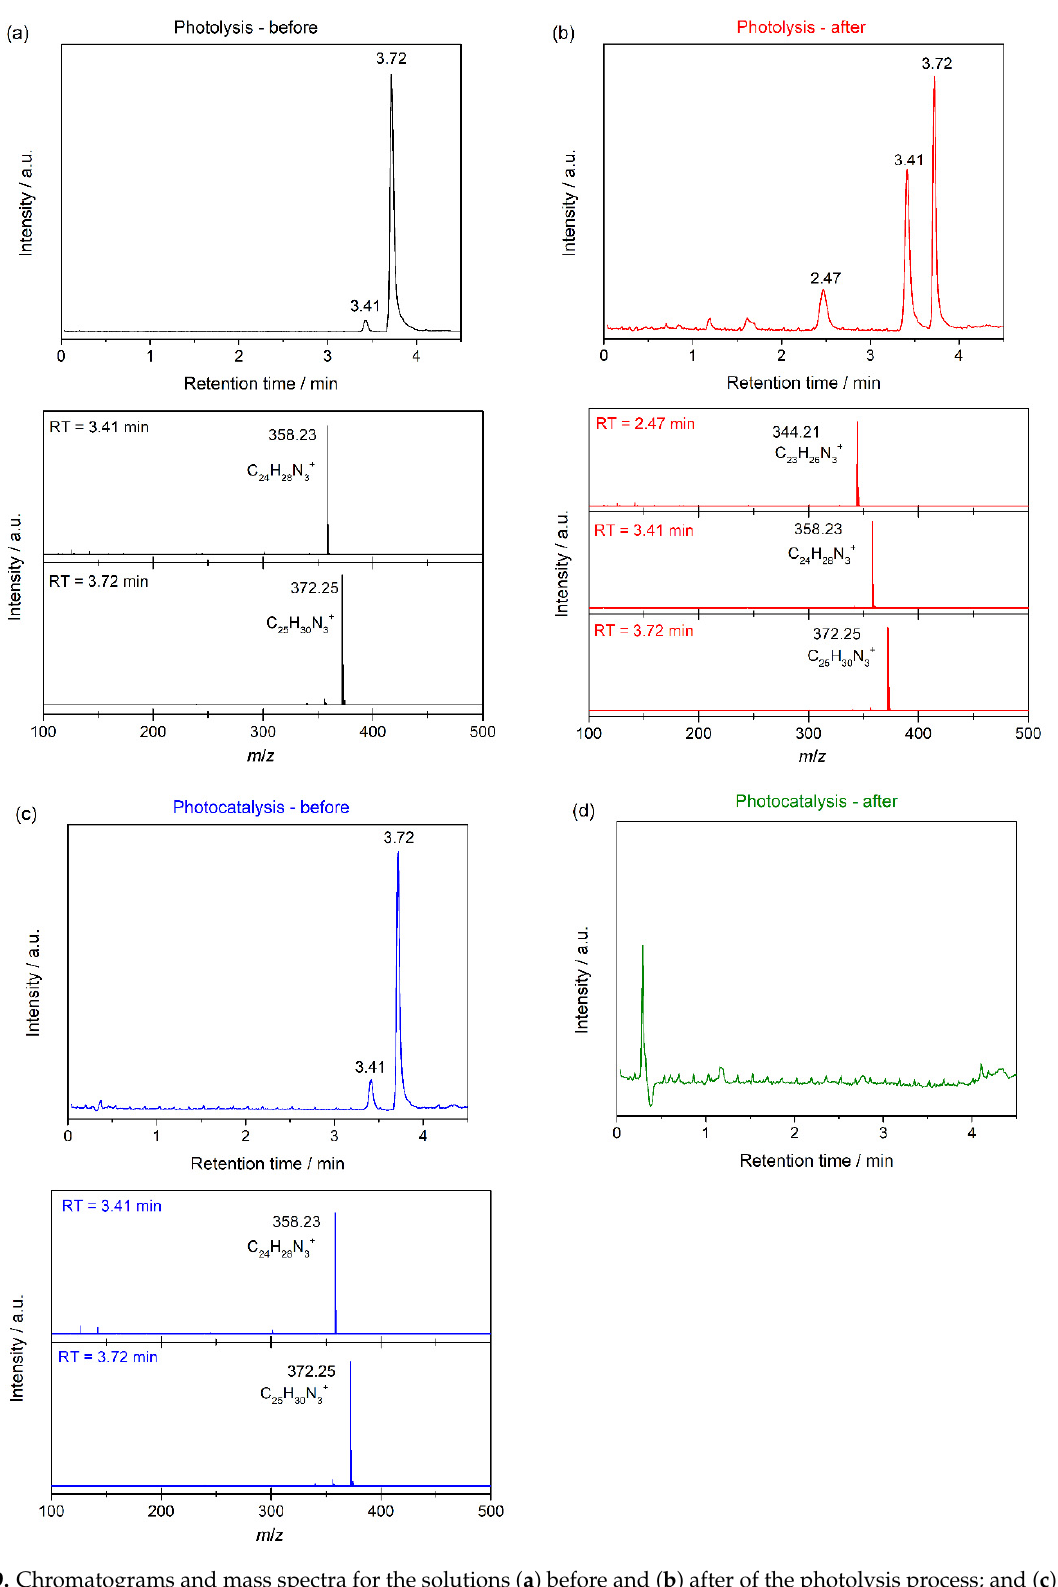
Figure 9. Chromatograms and mass spectra for the solutions ( a ) before and ( b ) after of the photolysis process; and ( c ) before and ( d ) after photocatalysis process.